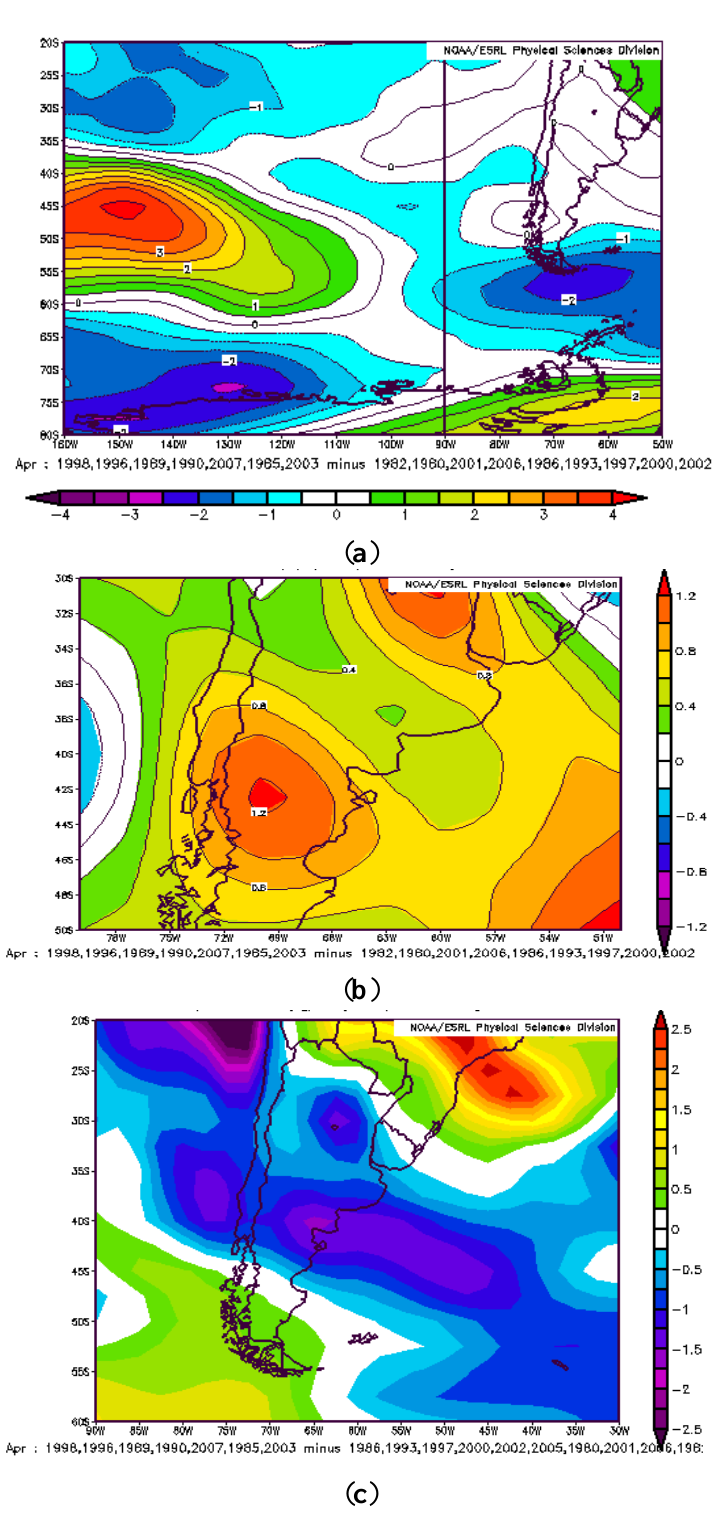
Figure 7. ( a ) 850 hPa zonal wind (in m/s), ( b ) 850 hPa meridional wind (in m/S) and ( c ) precipitable water (in Kg/m 2 ) difference composites between dry and wet years following the classification showed in Table